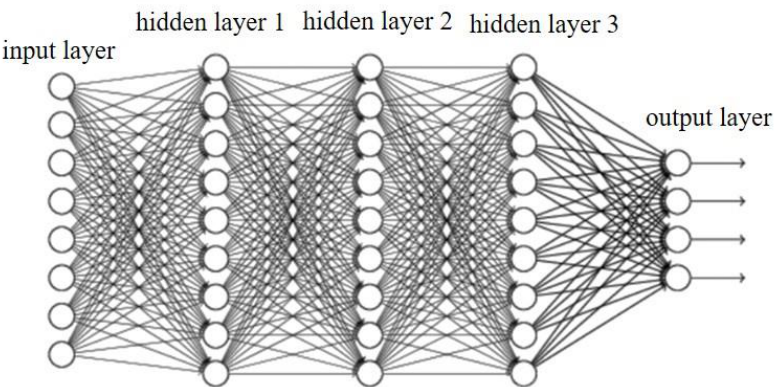
Figure 8. Neural network structure.